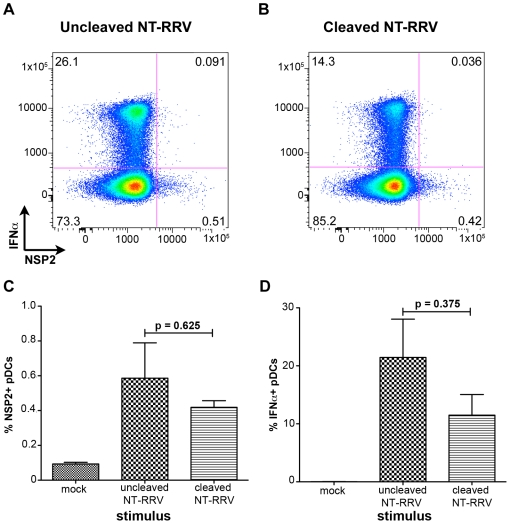
The effect of trypsin activation of rotavirus on pDC infection and IFNα induction.(A, B) Representative FACS plots of IFNα and NSP2 expression by pDCs exposed to equal quantities of non-trypsinized RRV (NT-RRV) with uncleaved (A, 3.77×105 focus forming units/ml; moi = 0.079) or cleaved (B, 2.38×107 focus forming units/ml; moi = 5) VP4. (C, D) Summary of percent NSP2+ and IFNα+ pDCs from multiple donors (n = 3) following exposure to cleaved or uncleaved RRV. p≥0.375; Wilcoxon signed rank test.